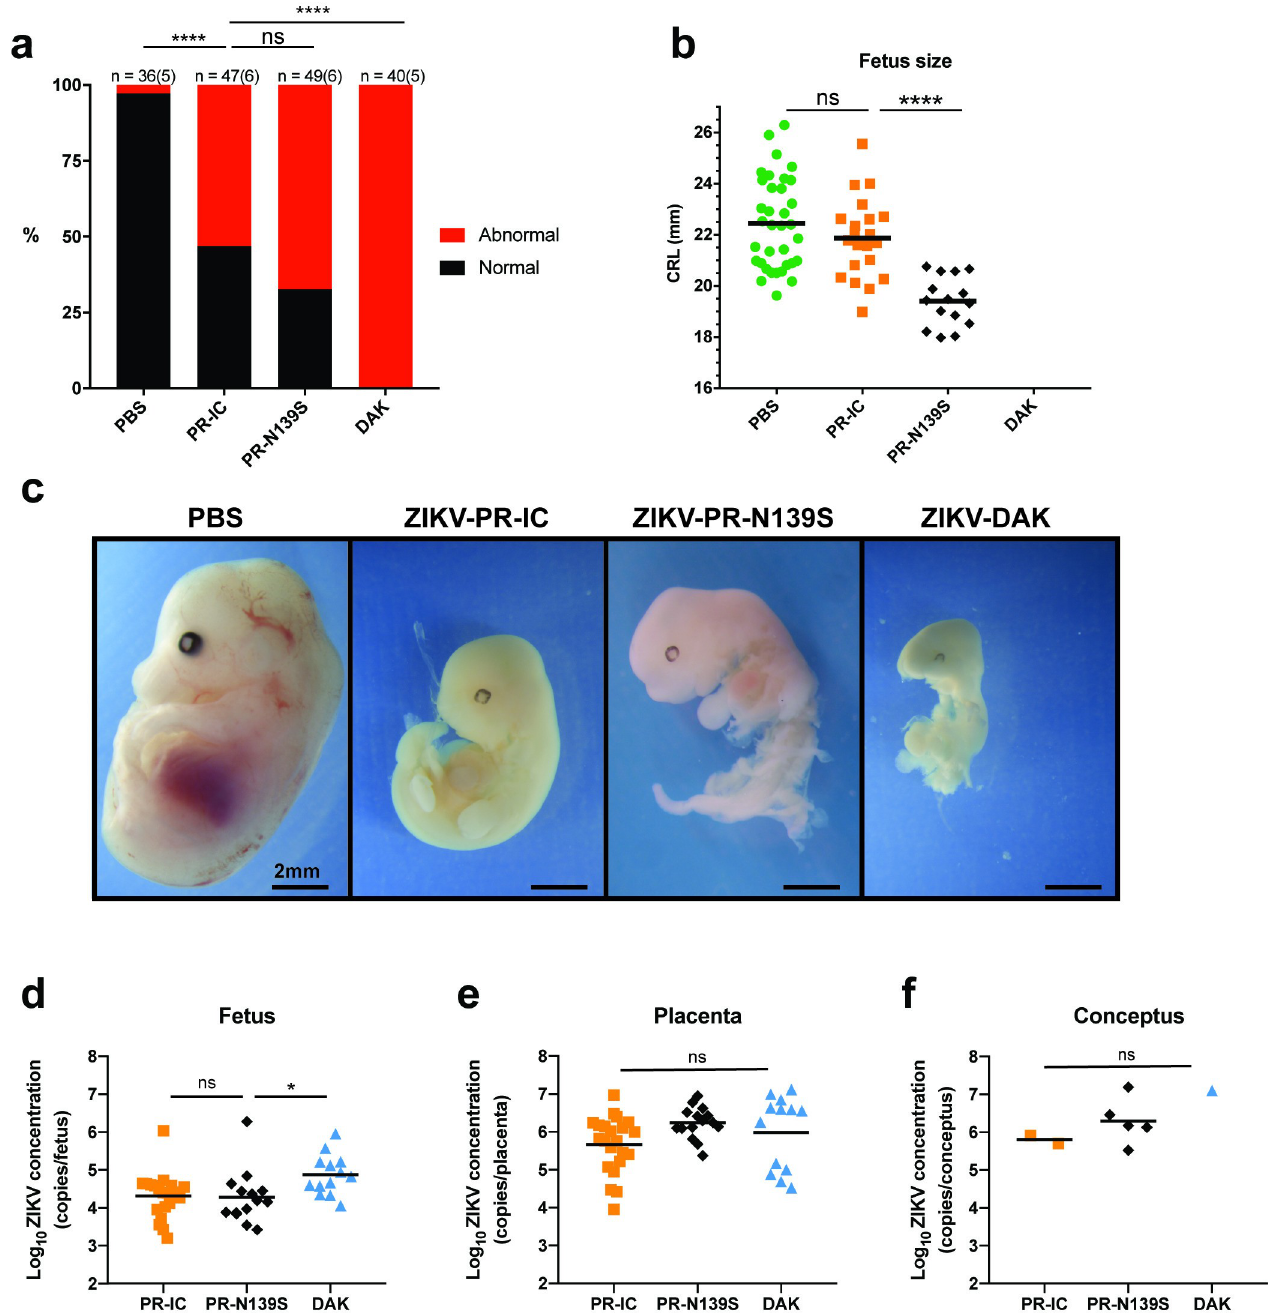
Fig 2. Fetal outcomes after maternal infection with ZIKV strains. (a) Rate of grossly normal (black) versus abnormal (red) fetuses at E14.5 after maternal infection at E7.5. An abnormal fetus was defined as resorption-prone. Data presented are for individual fetuses from 5–6 litters per treatment group. The n for each group is indicated above each bar. ���� p < 0.0001; ns, not significant (Fisher’s exact test). (b) Fetus size as assessed by crown-rump length (CRL) in mm using ImageJ software. CRL was only measured for fetuses determined to be grossly normal at E14.5. ���� p < 0.0001; ns, not significant (unpaired Student’s t- test). (c) Representative images of fetuses on E14.5 from each treatment group. Scale bar, 2 mm. PBS characterized as normal. ZIKV-PR-IC, ZIKV-PR-N139S, ZIKV-DAK characterized as abnormal. (d-f) Viral burdens were measured by qRT-PCR assay from individual homogenized placentas (d) , fetuses (e) , and concepti (when the fetus and placenta could not be separated due to severe resorption). (f) Symbols represent individual placenta, fetus, or conceptus from 3–5 independent experiments for each treatment group. Bars represent the mean viral burden of each treatment group. � p < 0.05; ns, not significant (one-way